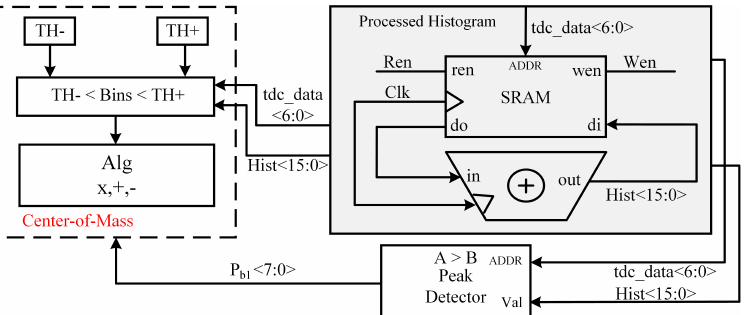
Figure 6. The implementation of the CoM